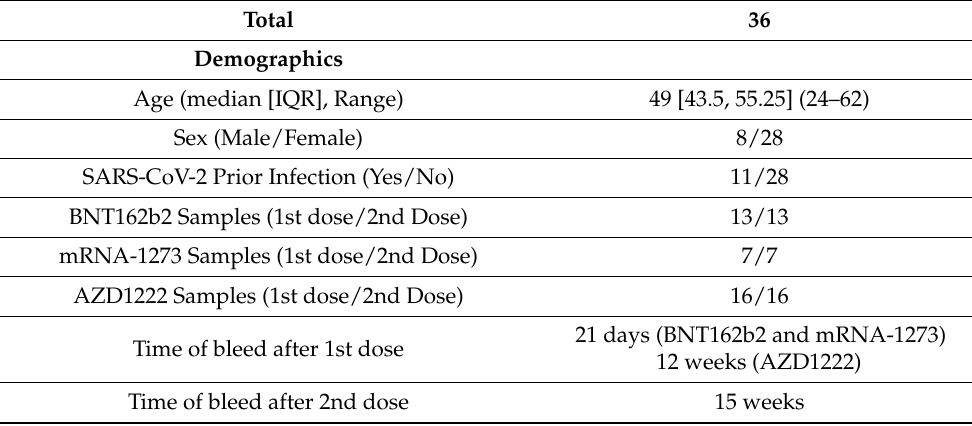
Table 1. Demographic and clinical characteristics of the cohort.